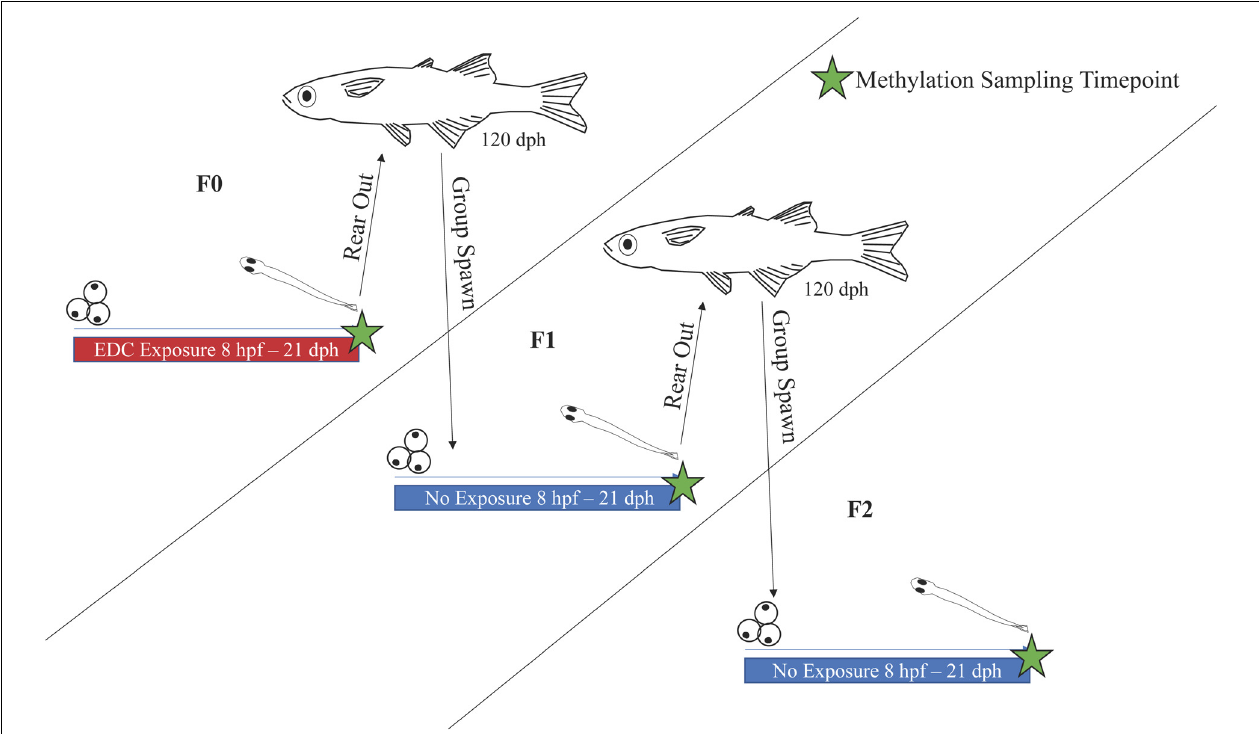
FIGURE 1 | Multigenerational experimental design for M. beryllina exposed to one of four different EDCs (Bif, EE2, Levo, or Tren) in the parental generation (F0) from 8 hpf through 21 dph. At 21 dph, a subset of larval fish were sampled for molecular endpoints, while the rest were reared in clean water to approximately 120 dph, after which time they were group spawned ( ∼ 50 individuals per tank). Conditions and sampling timepoints remained the same for F1 and F2 generation fish but without chemical exposure during early